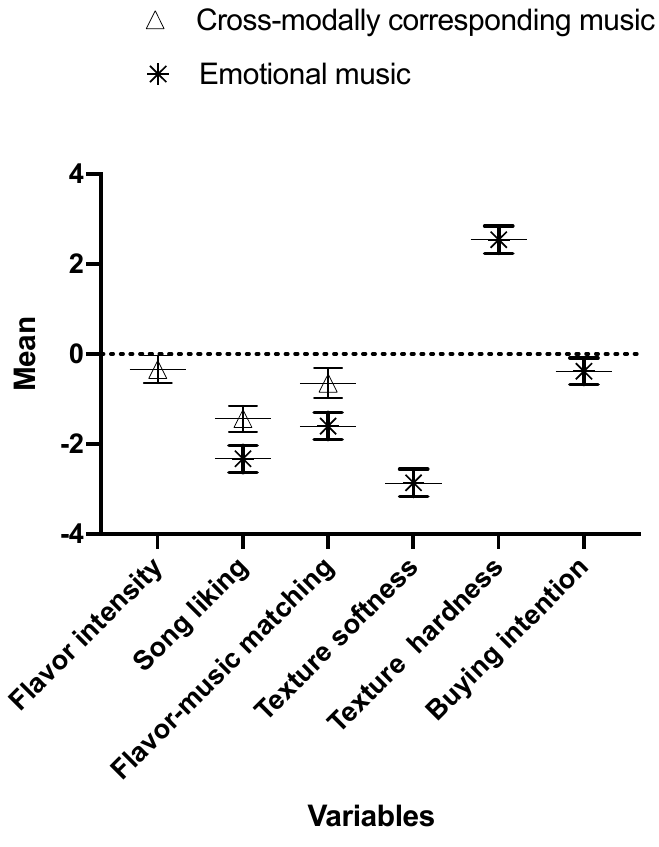
Figure 1. Summary of results where there is strong evidence that the associations being reported for each variable were not (solely) driven by the covariates, but are attributed to the effects triggered by the music while tasting the chocolates (except for WTP, since it was calculated via a different model). The results related to the music primarily chosen due to its cross-modal features are those where the posterior mean is being represented with a triangle. The results related to the music mainly chosen due to its emotional characteristics are those where the posterior mean is represented by an asterisk. Bars represent the upper and lower limit of the corresponding 95% credible interval.